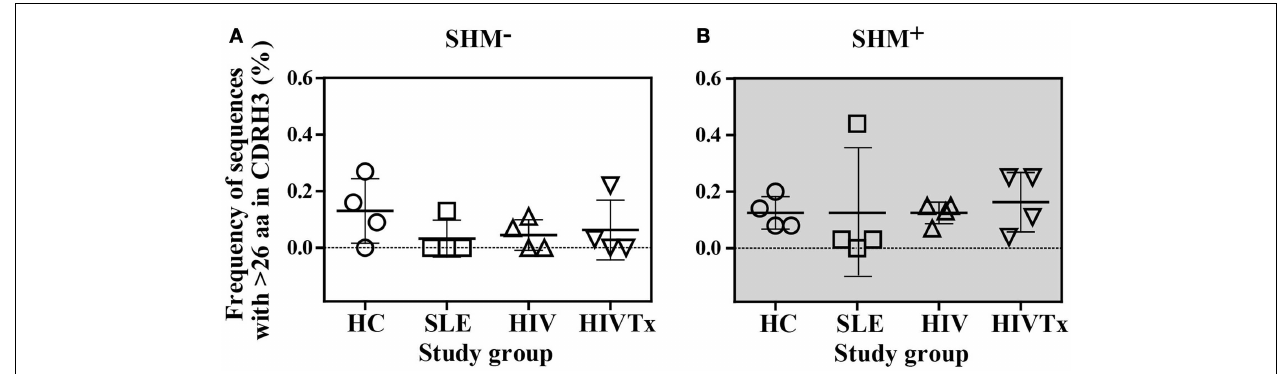
the four study groups. (B) . Among SHM + sequences, frequency of sequences with greater than 26 amino acids CDR3 length ranged from 0.13